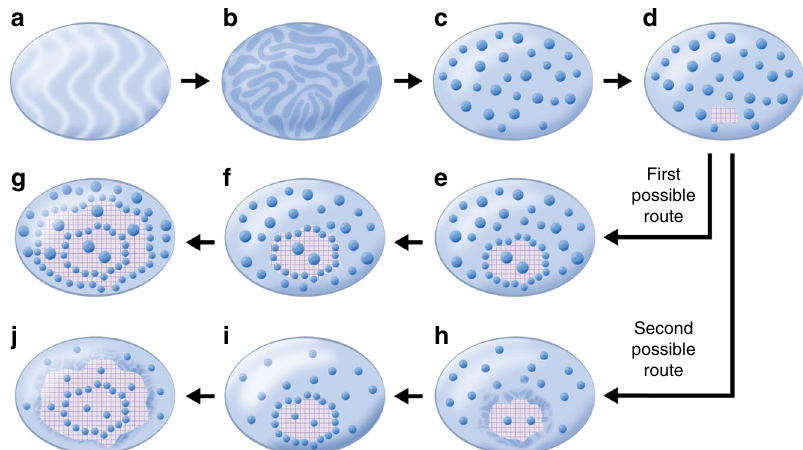
Fig. 8 Proposed mechanism of formation of layered structure. a Gel-like or liquid-like Mg-ACC precursor containing 15% MgCO 3 . b Decomposition starts from growing fl uctuations in concentration (spinodal decomposition of Mg-ACC solution). c Large Mg-concentration fl uctuations result in formation of Mg-rich nanoparticles. d At some point, a nucleus of crystalline Mg-depleted calcite appears. e, f First possible crystallization route: e the crystalline nucleus grows through the gel, rejecting small particles (below a critical size) and incorporates large particles (above the critical size). f Local gel viscosity increases owing to the increase in volume fraction of the particles reaching the critical value at which particles are trapped and coherently crystallize. g The process is repeated. h – j Second possible crystallization route: h Mg exclusion from crystallizing calcite and Mg enrichment of the vicinal Mg-ACC leads to secondary spinodal decomposition near the crystallization front. i Resulting formation of additional Mg-rich nanoparticles. j Advancement of crystallization front leading to formation of particle-enriched crystalline layer; thereafter the process of Mg exclusion and Mg-ACC secondary spinodal decomposition